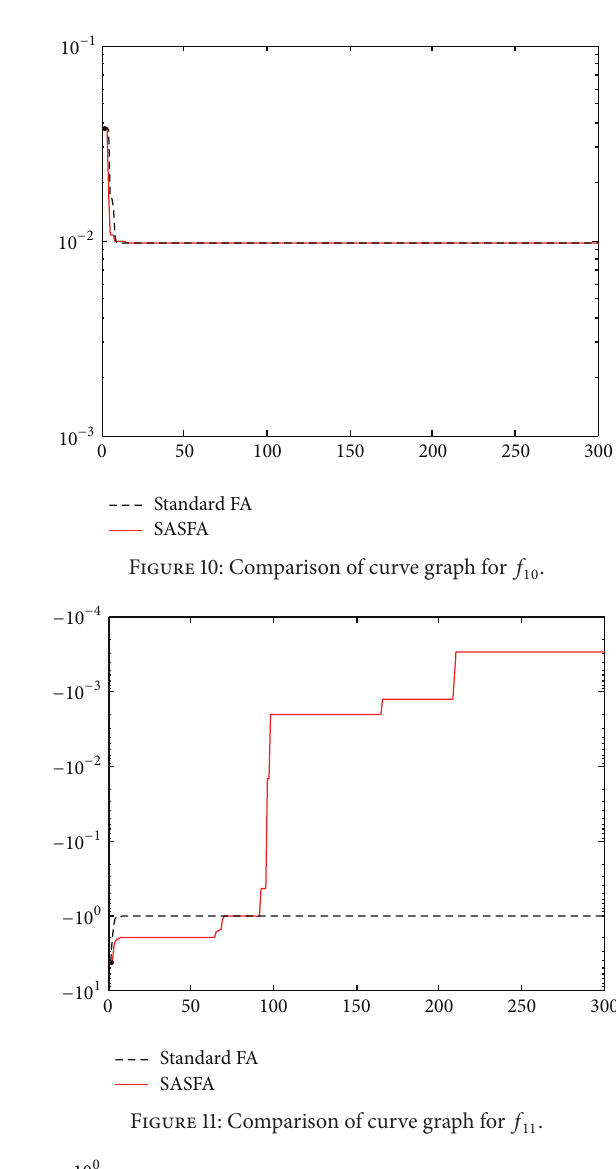
Figure 8: Comparison of curve graph for 𝑓 8 .